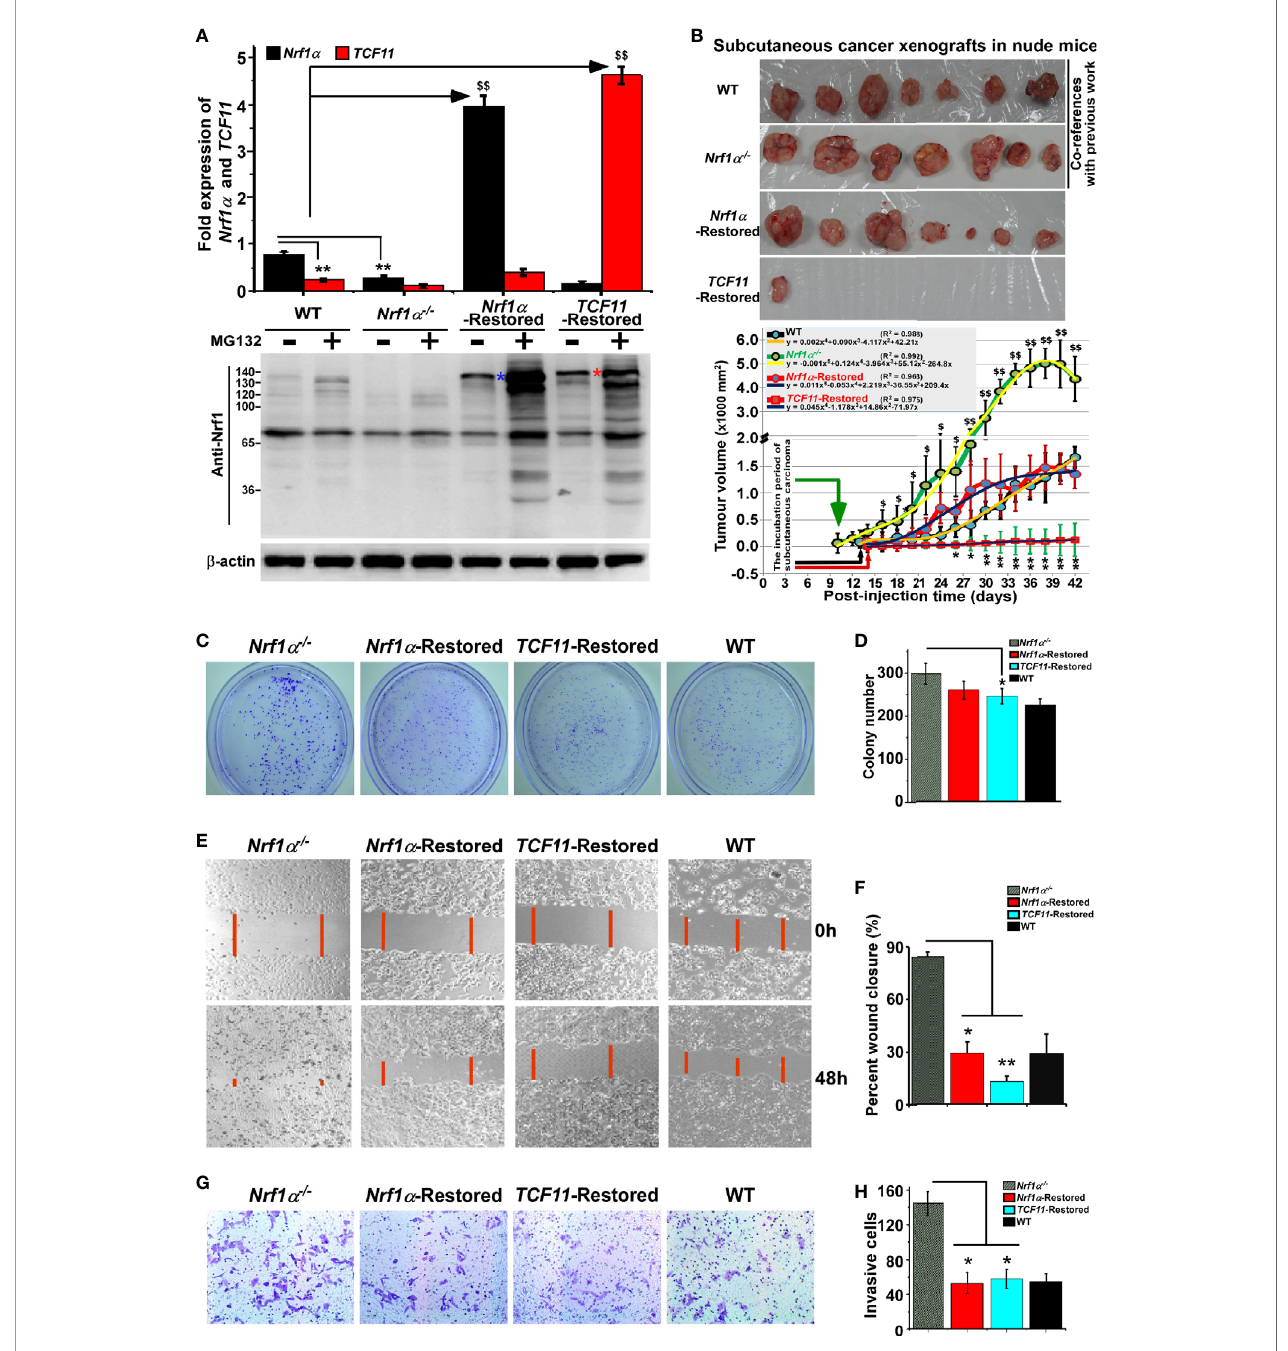
FIGURE 7 | Malgrowth of Nrf1 a − / − -derived hepatoma cells were signi fi cantly suppressed by restoration of Nrf1 a and TCF11 . (A) Both quantitative real-time PCR ( up ) and Western blotting ( down ) were employed to identify the protein and mRNA levels of Nrf1 a and TCF11 in Nrf1 a - and TCF11 -Restored hepatoma cells. The experimental cells had been treated with or without 10 m mol/L MG132 for 4 h before being harvested for Western blotting. The data are shown as mean ± SEM (n = 3 × 3, ** p < 0.01; $$ p < 0.01). (B) Differences in mouse subcutaneous xenograft tumors derived from wild type HepG2 (WT), Nrf1 a − / − , Nrf1 a -Restored and TCF11 - Restored cells were measured in size every two days, before being sacri fi ced on the 42nd day. The data are shown as mean ± SD (n = 7 per group, * p < 0.05; ** p < 0.01; $ p < 0.05; $$ p < 0.01, when compared with the WT group). (C – H) The soft agar colony formation (C, D) , as well as migration (E, F) and invasion (G , H) , of wild type HepG2 (WT), Nrf1 a − / − , Nrf1 a -Restored and TCF11 -Restored cells were examined as described in Materials and Methods . The data are shown as mean ± SD (n = 9, * p < 0.05, ** p <